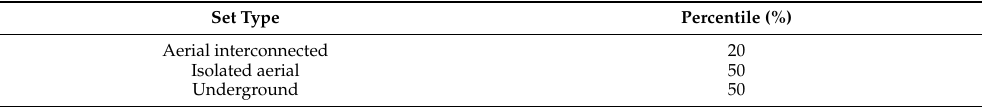
Table 19. Percentile adopted by type of